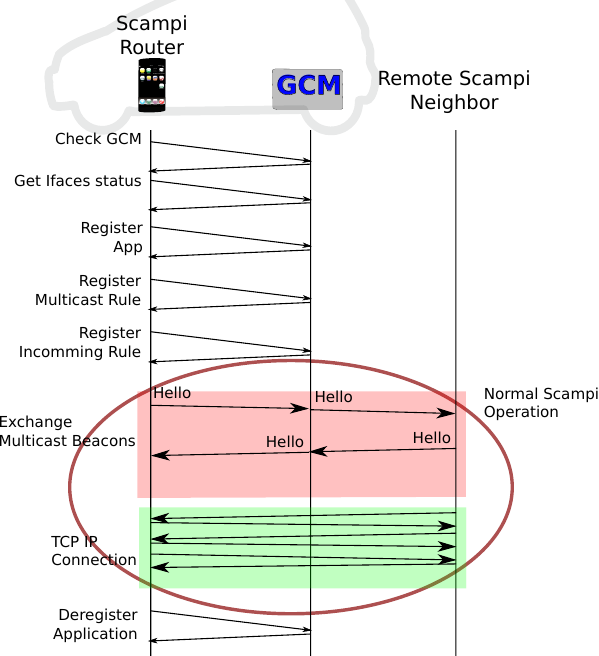
Figure 6: Example of integration between Scampi and